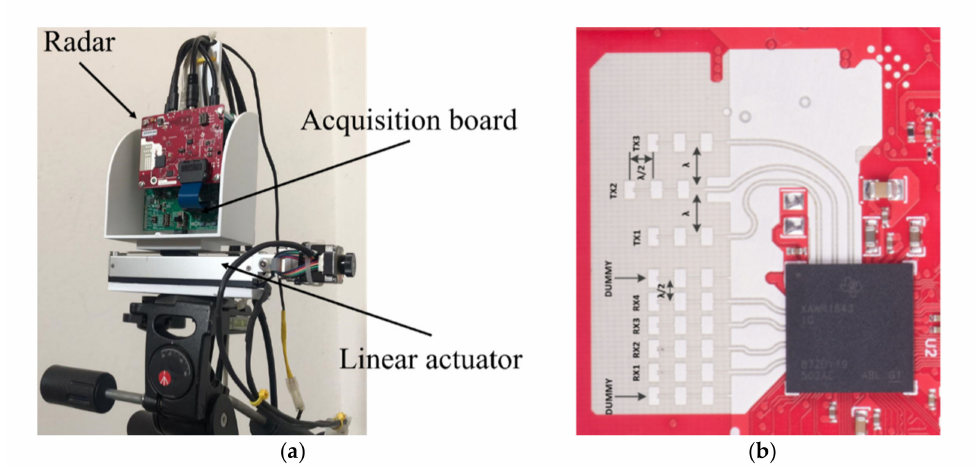
Figure 5. Prototype of GB-SAR ( a ), and details of the antennas’ configuration ( b ).